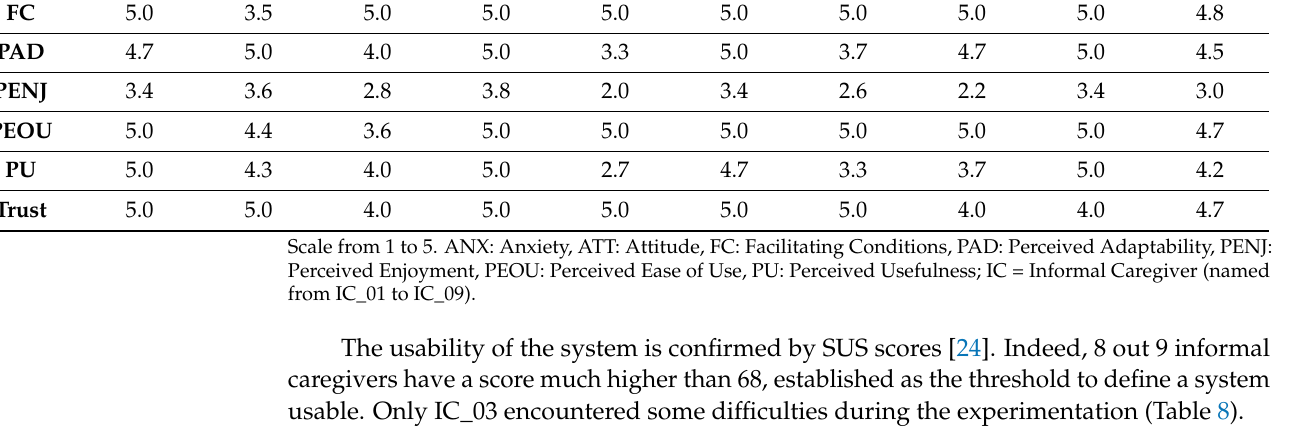
Table 7. UTAUT scales scores of informal caregivers at the end of the test.